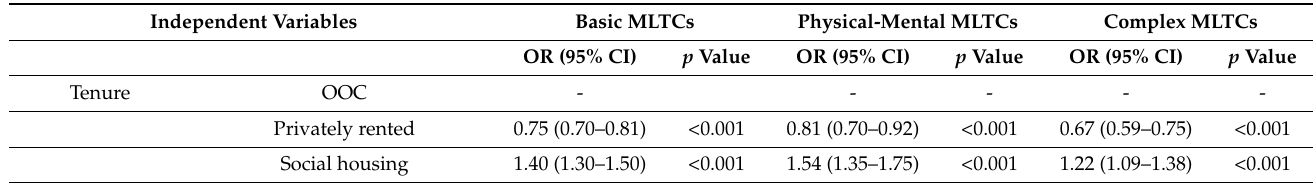
Table A6. Estimated odds ratios of basic, physical-mental, and complex MLTCs with household tenure when the final models tested for interactions between tenure and household type for working- age adults residing in B&D in 2019/20 (N =